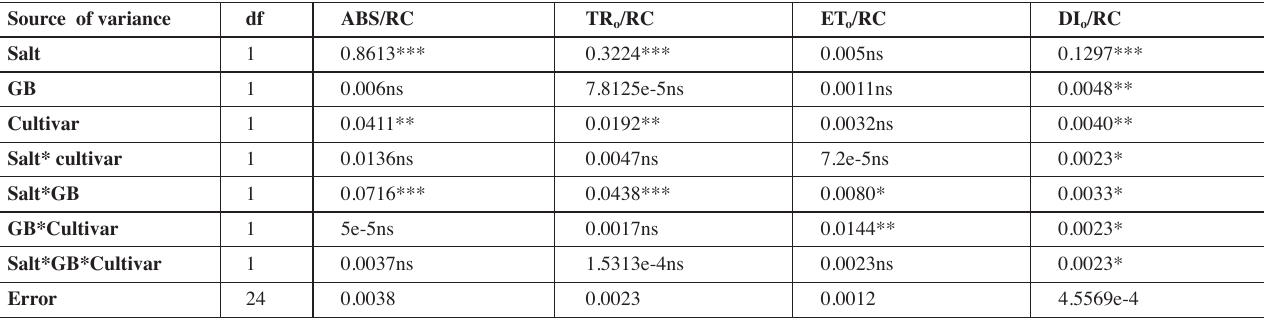
Tab. 4: Mean squares from analysis of variance of data for ABS/RC, TR o /RC, ET o /RC and DI o /RC in leaves of two cultivars of canola ( Brassica napus L.) treated with or without foliar spray of GB to salt stressed and non stressed